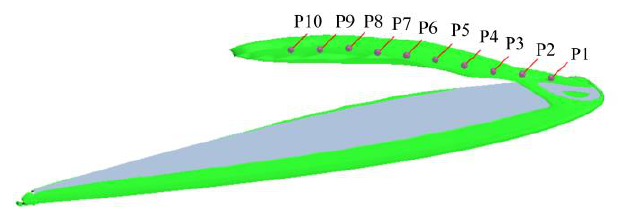
Figure 9. The TLV pattern and trajectory of the case MST ( Q = 3 × 10 6 s − 2 ).